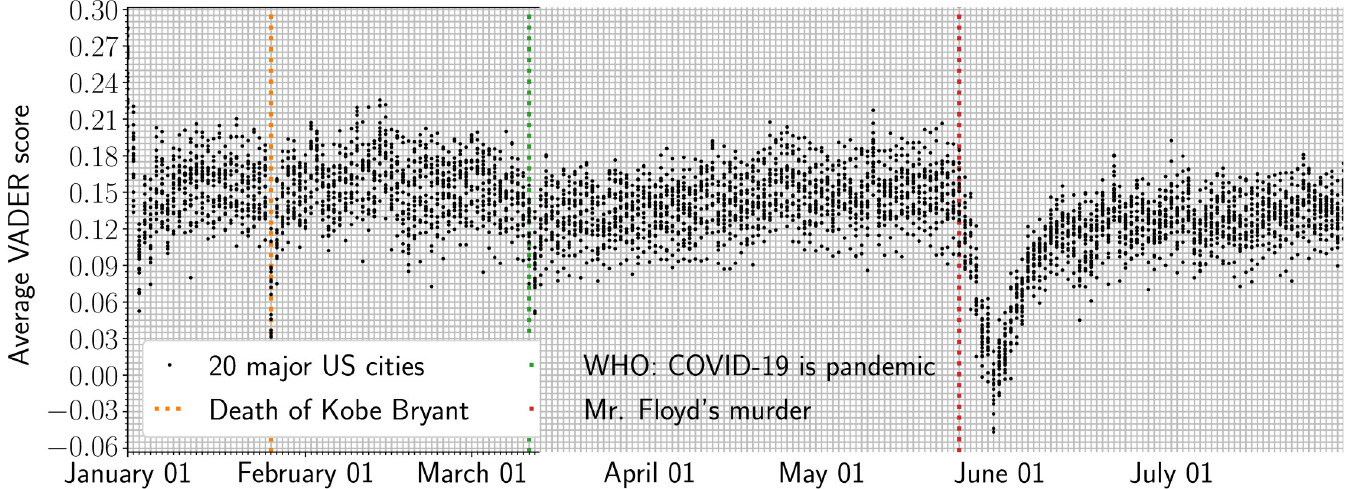
Fig 2. Average longitudinal VADER scores across 20 US cities. Dotted lines represent notable declines in sentiment spurred by 3 acute events: (1) Kobe Bryant’s death, (2) when the World Health Organization (WHO) declared COVID-19 a pandemic, and (3) Mr. George Floyd’s murder. The distribution of sentiment values indicates a sharper drop of SWB with each subsequent event, including a longer time to stabilize at slightly lower levels than before, possible indicating increasing hysteresis effect on societal mood. The effect is particularly pronounced after Mr. Floyd’s murder.